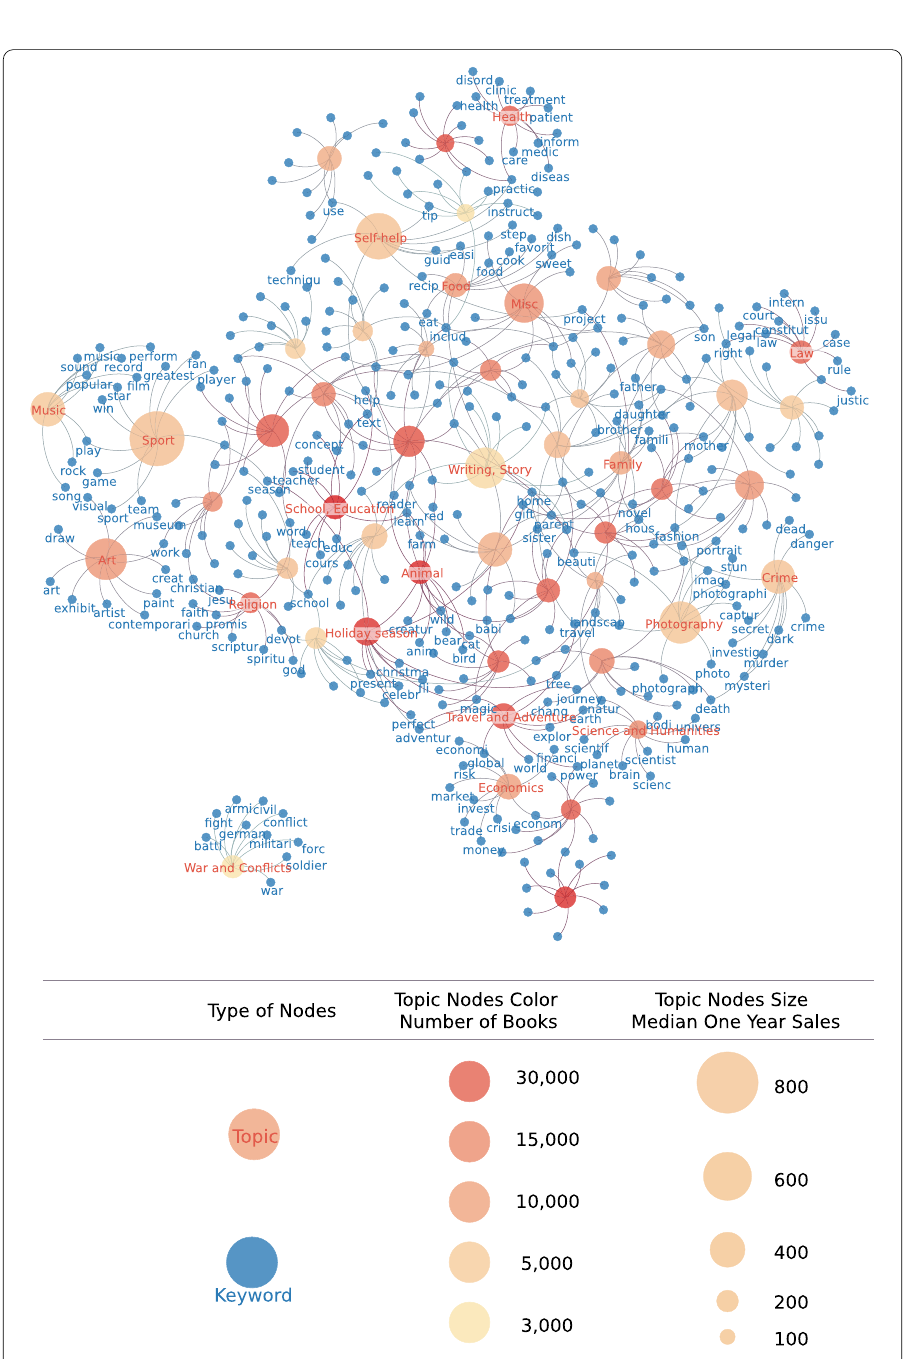
Figure 2 Bipartite graph of topics and keywords. The graph was obtained through a Non-negative Matrix Factorization (NMF) process. For each topic, we select the top 10 keywords. Nodes with red labels are topics nodes where the color corresponds to the number of books under this topic (colors reflects the size of the nodes with gradient between yellow to red, indicating smallest and largest, respectively), and the size is proportional to the median sales of books under the topic. Nodes with red labels or blue nodes without labels are the keywords. For example, under topic Sport we see keywords like “team”, “fan”, “play”, under topic Science andHumanities we can find keywords like “scientist”, “planet”, “explore”. We also see that the topic Sport has a moderate number of books and its sales of the topic is one of the best. For the topic ScienceandHumanities , it has more books than Sport , but the sales of the topic is lower than